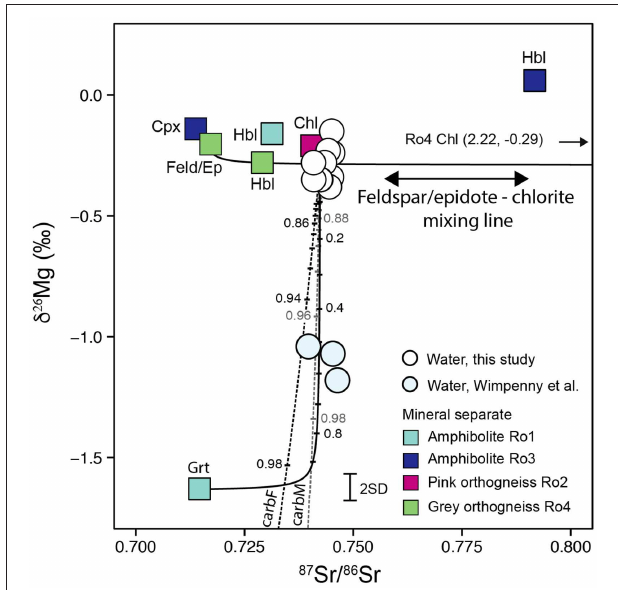
FIGURE 5 | δ 26 Mg vs. 87 Sr/ 86 Sr. Previous work demonstrated the dominance of orthogneiss Ro4, in particular chlorite, feldspar, and epidote, to the dissolved and sediment load of the Leverett River ( Hindshaw et al., 2014; Rickli et al., 2017). The mixing line between chlorite and feldspar/epidote in Ro4 is shown. The point where this line has the same 87 Sr/ 86 Sr value as the average of the river water samples (0.742435, Hindshaw et al., 2014) is defined as “Ro4-Leverett.” The garnet end-member is defined in Table 1 . Two carbonate end-members are defined based on acetic acid leaches of a felsic (carbF) and a mafic (carbM) rock from Akuliarusiarsuup Kuua River (AKR) (Andrews and Jacobson, 2018) and a δ 26 Mg carbonate value of –3.2 h ( Wimpenny et al., 2011). Mixing lines between Ro4-Leverett and carbonate (dashed lines) and Ro4-Leverett and garnet (solid line) are shown and assume congruent dissolution of each end-member. The numbers indicate the mass fraction of the garnet or carbonate end-member. Mineral abbreviations: Hbl, Hornblende; Chl, Chlorite; Cpx, Clinopyroxene; Grt, Garnet; Feld/Ep, K-feldspar, plagioclase, epidote